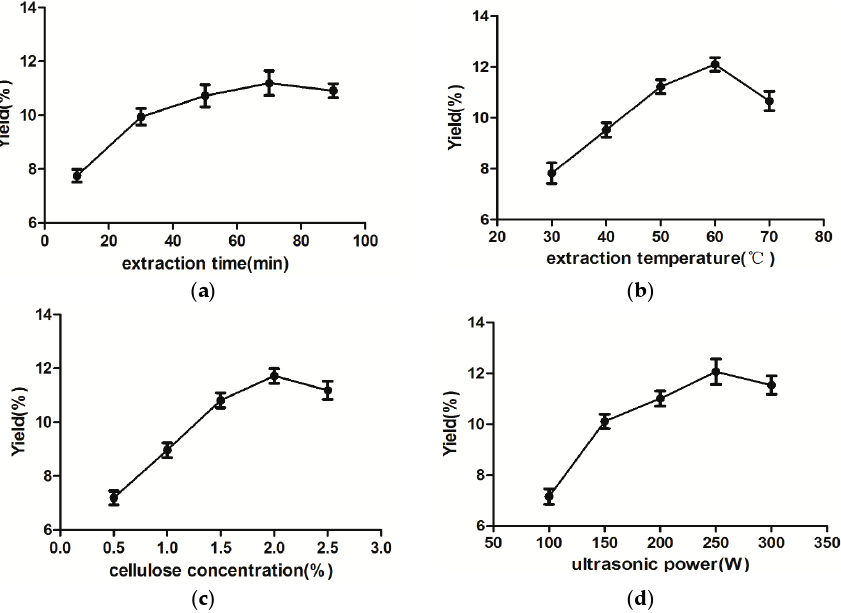
Figure 1. Effects of extraction time ( a ) extraction temperature ( b ) cellulase concentration ( c ) and ultrasonic power ( d ) on the extraction yield of RAMP (%).